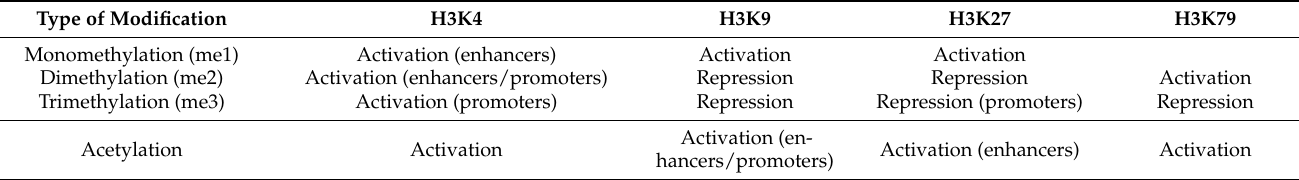
Table 1. Functional roles of histone 3 modifications at lysine residues 4, 9, 27, and 79. Type of